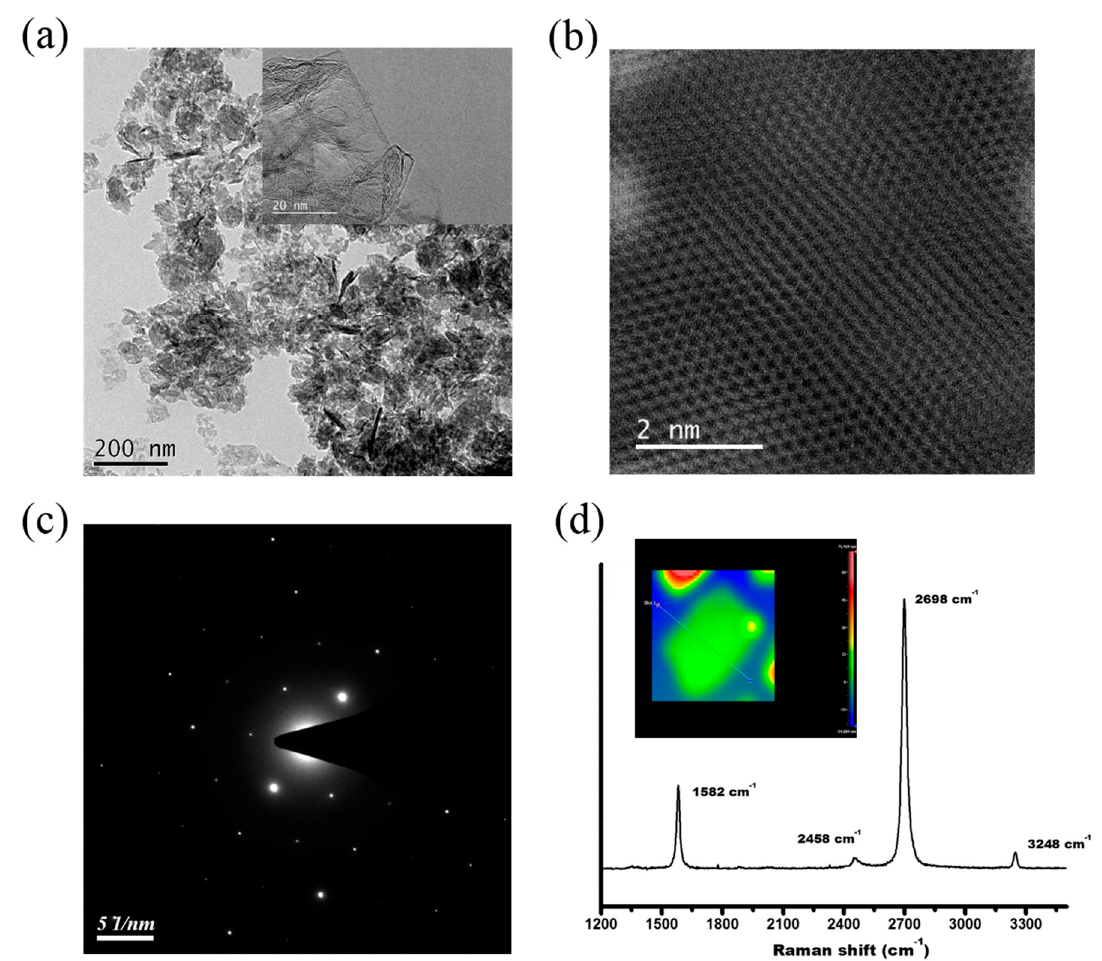
Figure 1. ( a ) Transmission electron microscopy (TEM) micrograph of ultra-high shear force-treated reduced graphene oxide hydroxyapatite nanocomposites (r-GO/HA NCPs). The inset shows the r-GO with only a few layers. ( b ) High-angle annular dark-field (HAADF) image of r-GO. ( c ) Electron diffraction pattern of r-GO. ( d ) Raman spectrum of ultra-high shear force-treated r-GO. The inset shows the layer thickness of the r-GO to be around 15 nm.